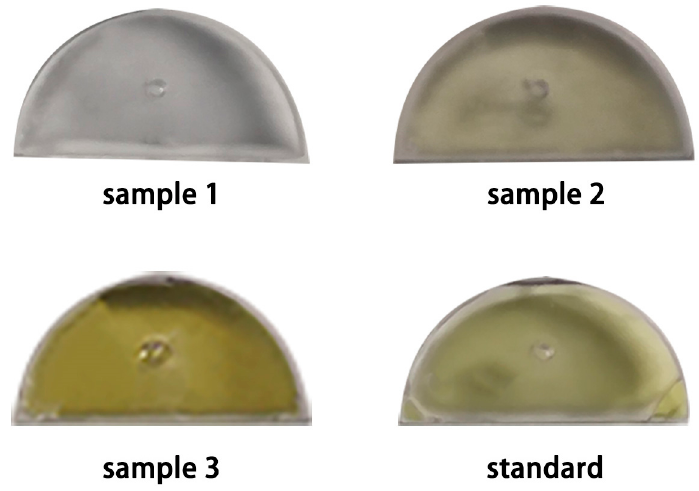
Figure 5. Color result diagrams of actual samples detected by biological logic gates. Table 1. Comparison of actual sample results by different methods.